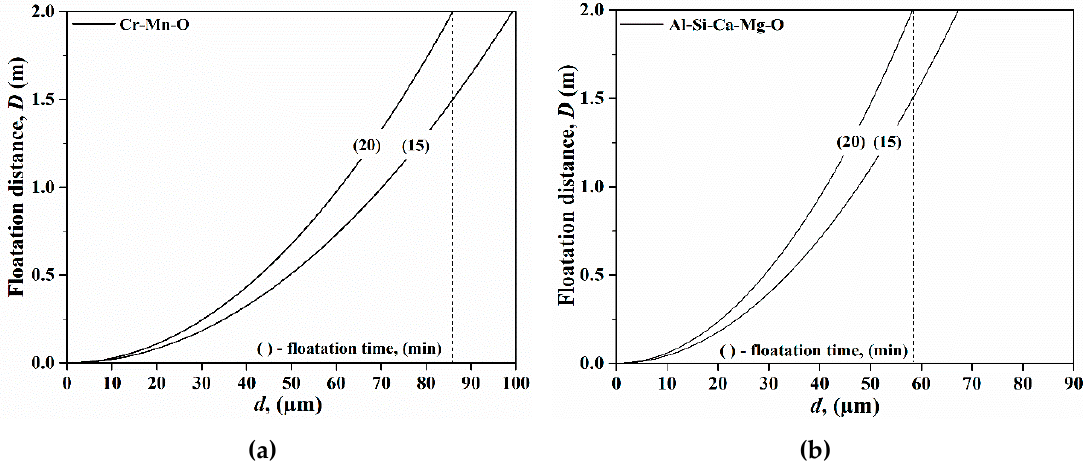
Figure 7. The floatation distances for Cr-Mn-O ( a ) and Al-Si-Ca-Mg-O ( b ) inclusions in liquid steel.